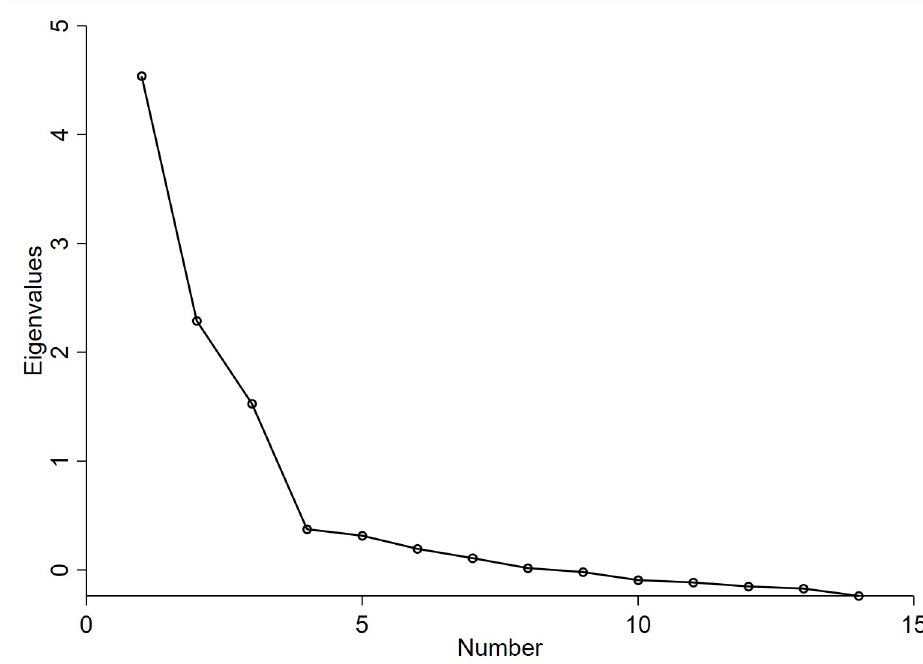
Fig 1. Scree plot for determining factors of the designed instrument (Sample 1, n =